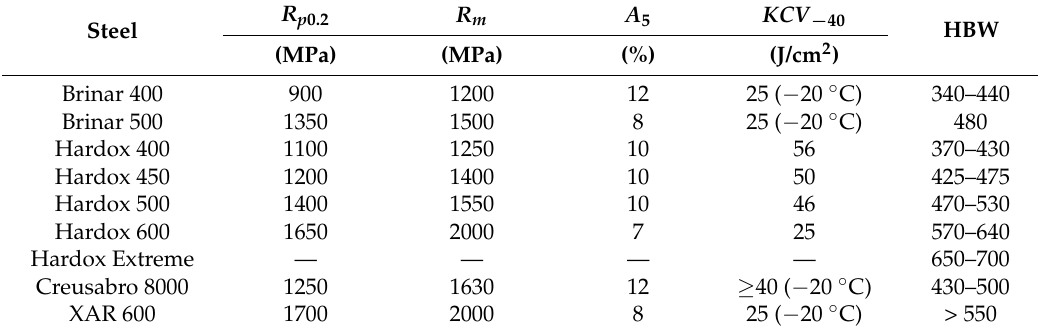
Table 1. Properties of selected low-alloy high-strength, abrasive-wear resistant steels [10–15]. Steel